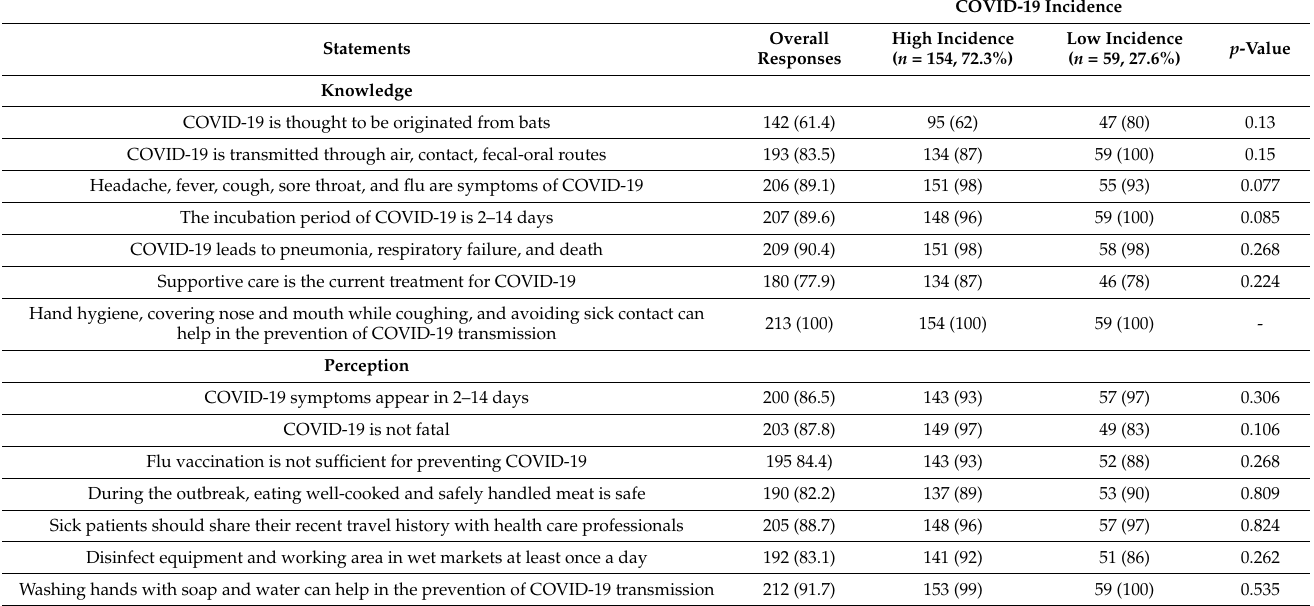
Table 3. Healthcare workers responses to knowledge, perception, and risk prevention practices based on COVID-19 incidences in Afghanistan ( n =